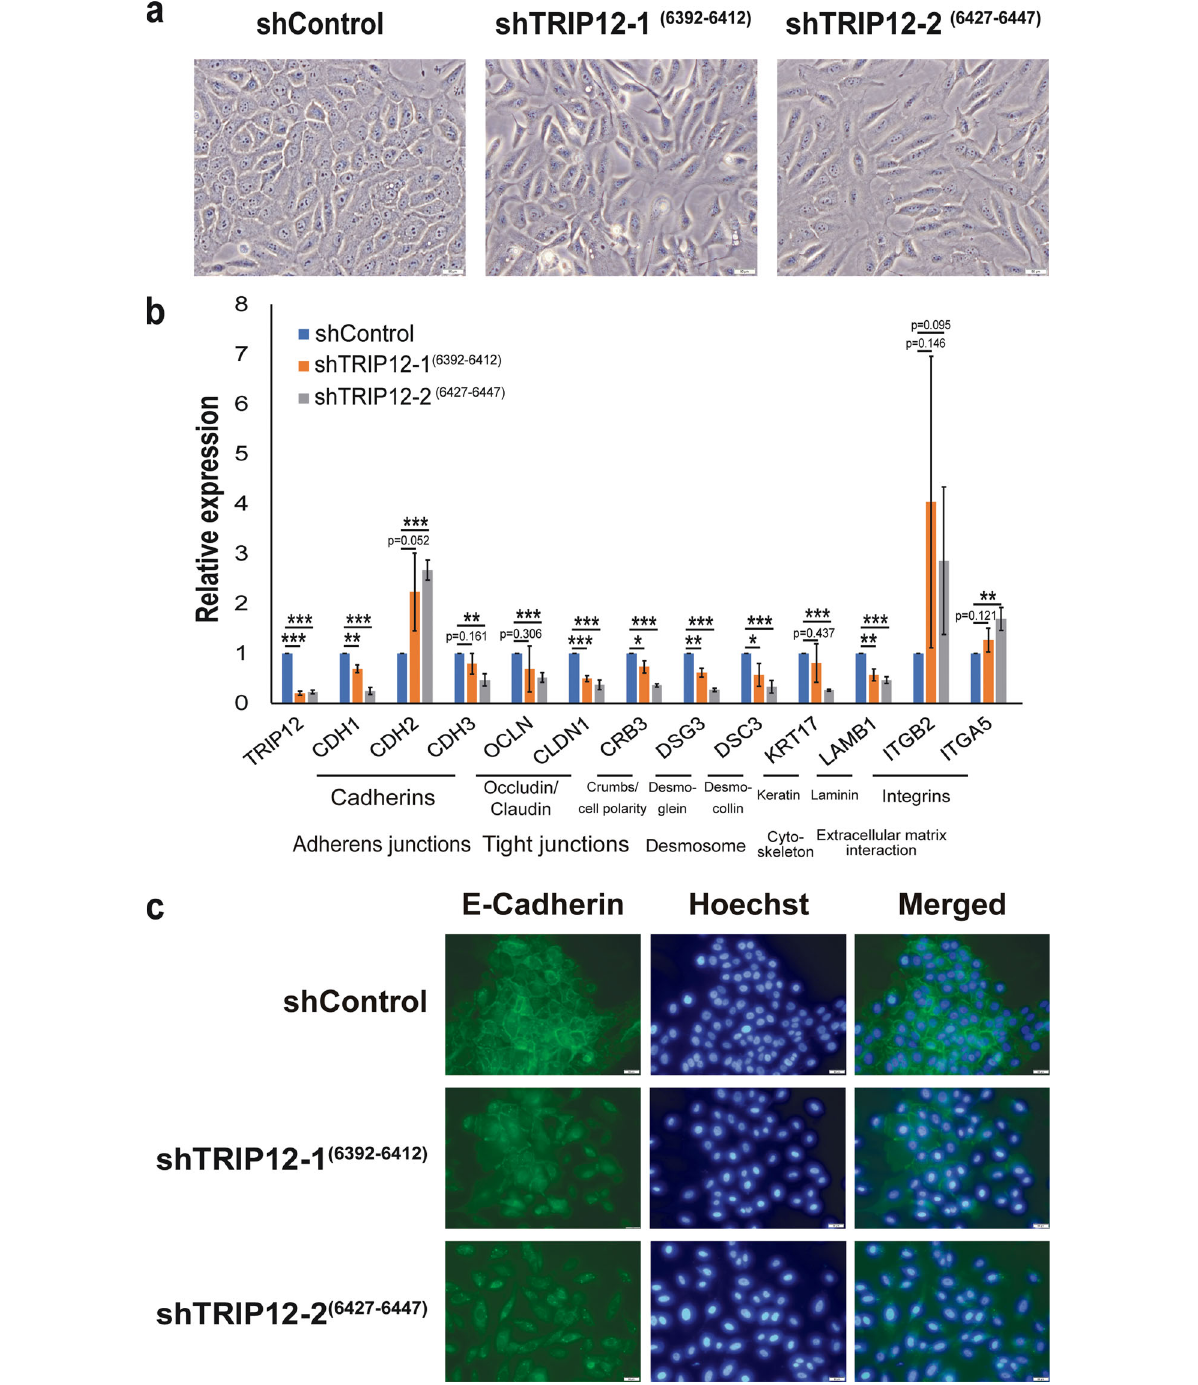
Fig. 3 TRIP12 regulates EMT cell adhesion genes involved in adherens junctions, tight junctions, desmosomes, cytoskeleton, and extracellular matrix interaction. a Bright- fi eld images showing the cellular morphology of MCF10A shControl, shTRIP12-1 (6392 – 6412) and shTRIP12- 2 (6427 – 6447) . Images were taken at 20X magni fi cation. The scale bar at the bottom right corner = 50 µm. ( N = 1). b Relative expression of the mRNA levels of EMT markers in MCF10A cells stably depleted of TRIP12. Relative expression levels were normalized to Actin mRNA levels and data quanti fi ed relative to shControl. ( N = 3). Data represent means ± SD. * p value < 0.05; ** p value < 0.01; *** p value < 0.001. c Fluorescent images of MCF10A shControl, shTRIP12-1 (6392 – 6412) and shTRIP12-2 (6427 – 6447) immunostained using an E-cadherin antibody and with Hoechst dye. Images were taken at 20X magni fi cation. The scale bar at the bottom right corner = 50 µm. ( N = 1).